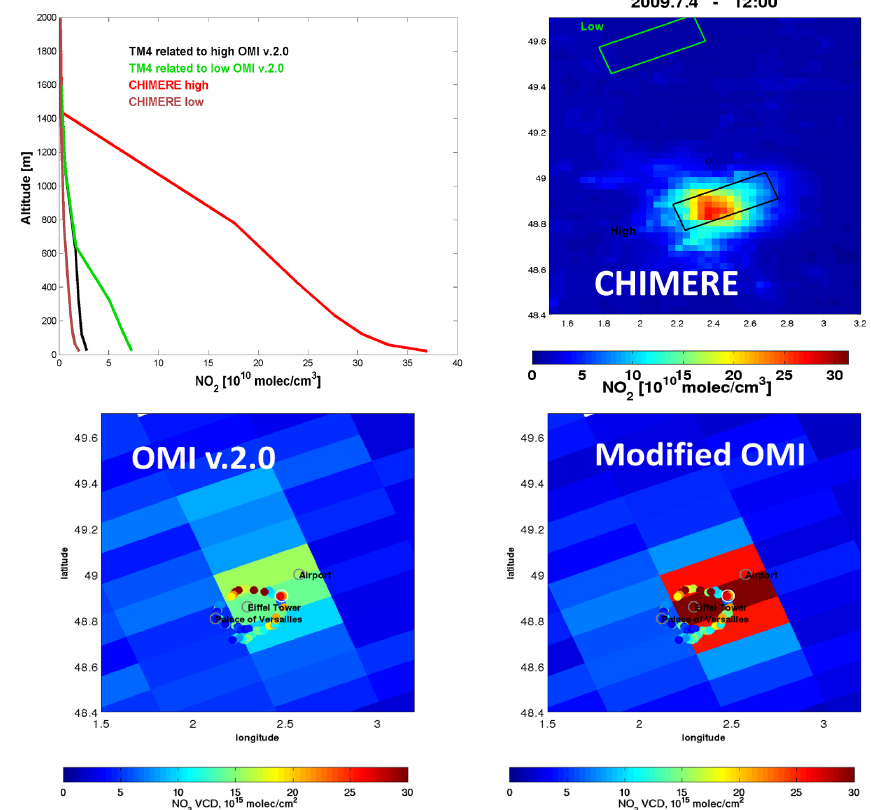
Figure 14. (a) Comparison of the vertical NO 2 profiles from TM-4 and CHIMERE for locations inside or outside the emission plume on 4 July 2009; (b) near-surface (0–44m) NO 2 concentrations from CHIMERE and locations of the selected profiles; (c) OMI results from the operational product (v2.0); Modified OMI results using the NO 2 profiles from the regional CHIMERE